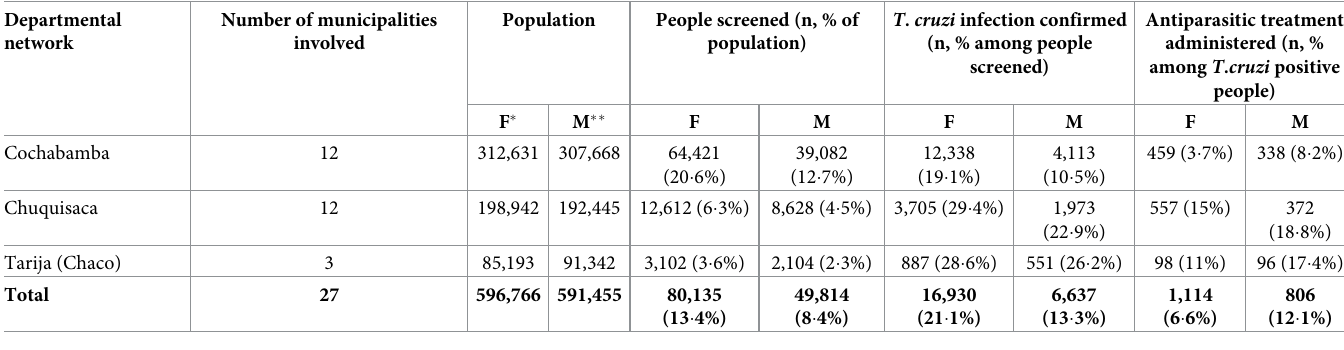
Table 1. Chagas network health coverage (2015–2018).